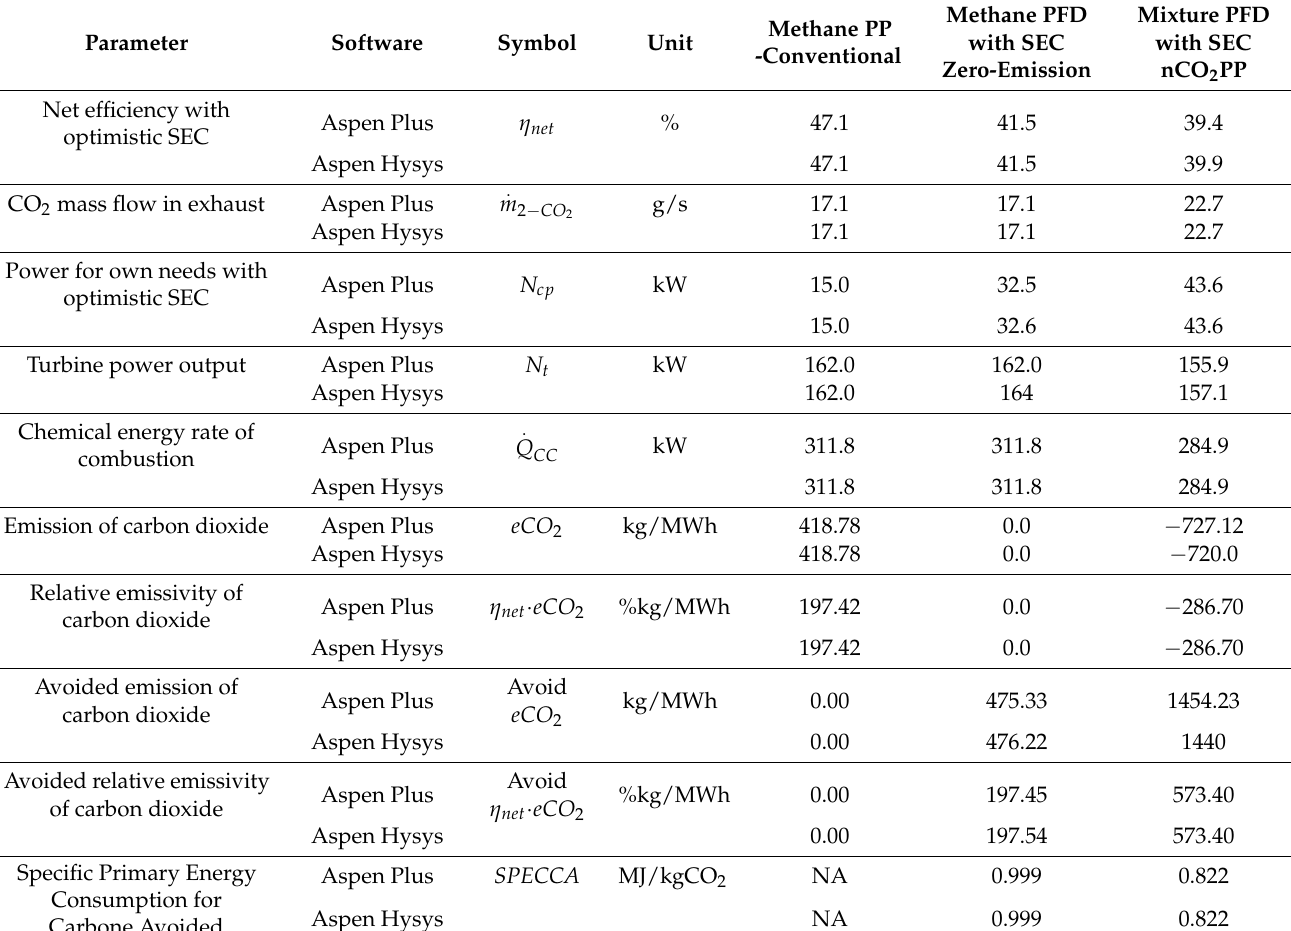
Table 13. Negative emission power plant effect—results for Aspen